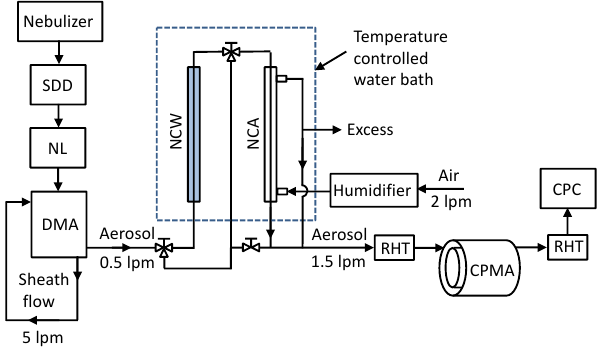
Figure 1. Experimental set-up of the hygroscopicity centrifugal par- ticle mass analyser (HCPMA) system: SDD (silica gel diffusion dryer), NL (aerosol neutralizer), DMA (differential mobility anal- yser), NCW (Nafion conditioner with water), NCA (Nafion con- ditioner with air), RHT (relative humidity and temperature sensor), CPMA (centrifugal particle mass analyser), CPC (condensation par- ticle